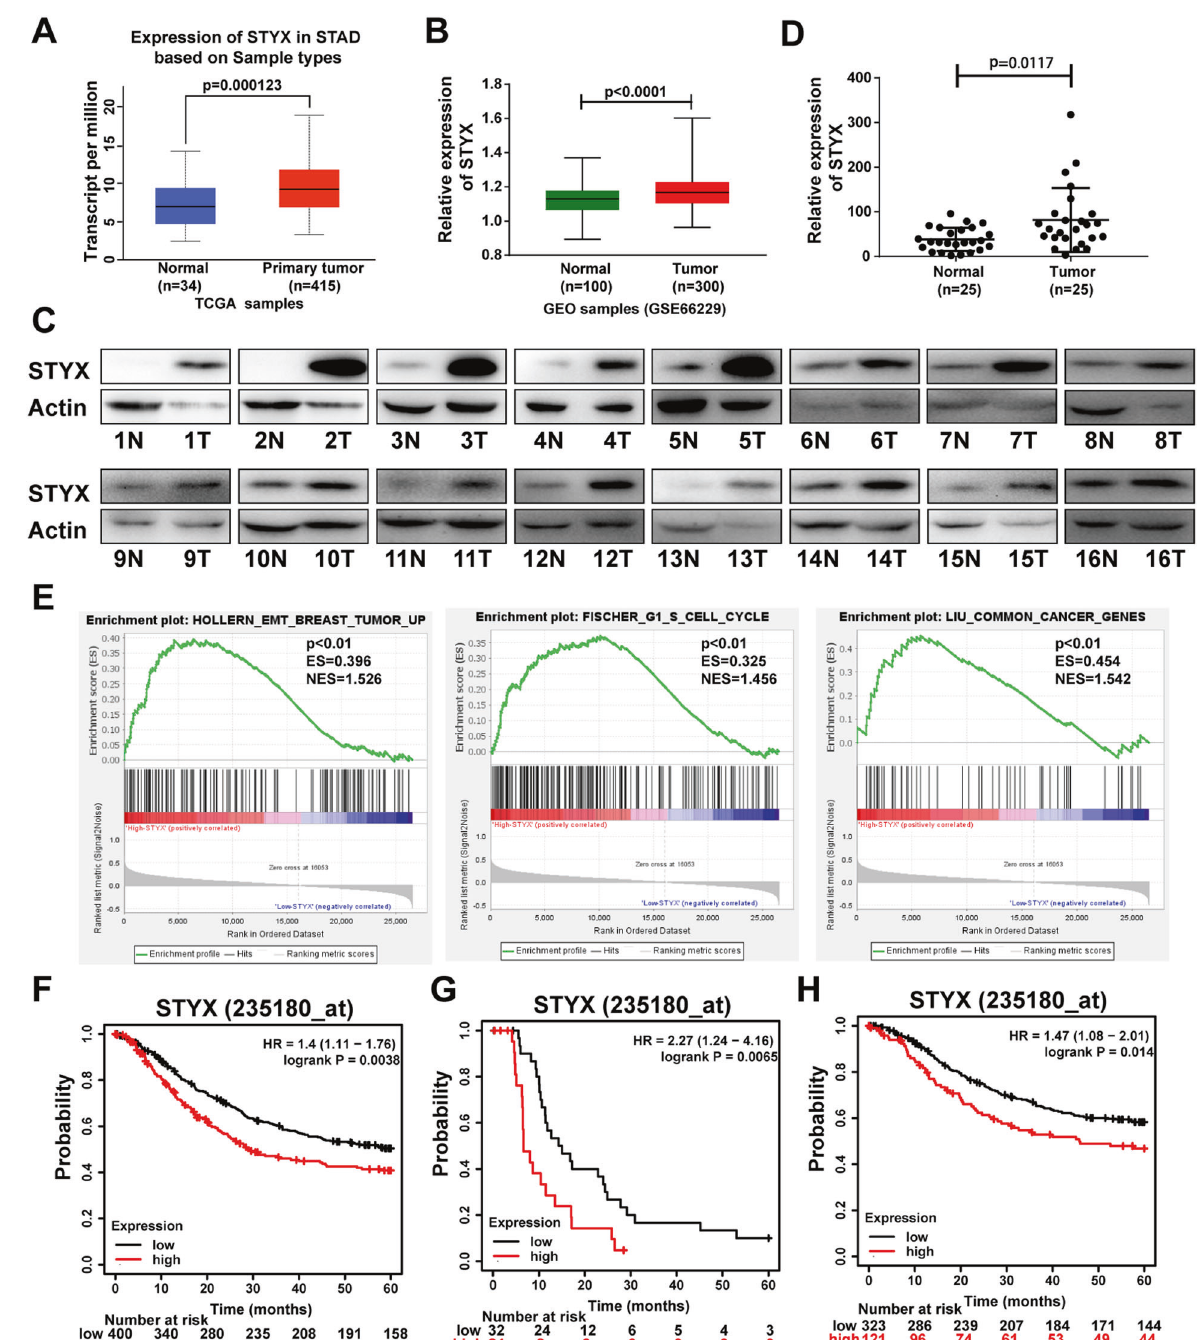
Fig. 1 STYX is highly expressed in GC, and the expression level of STYX is associated with the prognosis of GC patients. A Analysis of mRNA expression level of STYX in GC tissues and non-tumor tissues according to TCGA database. B Analysis of mRNA expression level of STYX in GC tissues according to GEO (GSE66229) database. C The protein expression of STYX was detected using western blot in 25 pairs of GC tissues and the adjacent non-tumor tissues of patients (N: non-tumor tissue, T: tumor tissue). The representative results were showed. D The protein expression of STYX in the GC tissues and the corresponding non-tumor tissues was measured using the ImageJ software and normalized to the expression of β -actin. The data were statistically analyzed using GraphPad Prism v7.0 4 software with a paired Student t -test. E Enrichment plots of gene expression signatures for EMT, Cell cycle and common cancer genes according to STYX mRNA expression in a published cohort (http://www.cbioportal.org/, TCGA, Nature 2014). The barcode plot indexed the position of the genes in each gene set. Red and blue colors indicated high and low level of STYX. ES enrichment score, NES normalized enrichment score. F The Kaplan – Meier Plotter database analyzed the overall survival (OS) of GC patients in relation to the STYX levels. G The Kaplan – Meier Plotter database analyzed survival of GC patients with lymph node metastasis. H The Kaplan – Meier Plotter database analyzed survival of GC patients without lymph node metastasis.